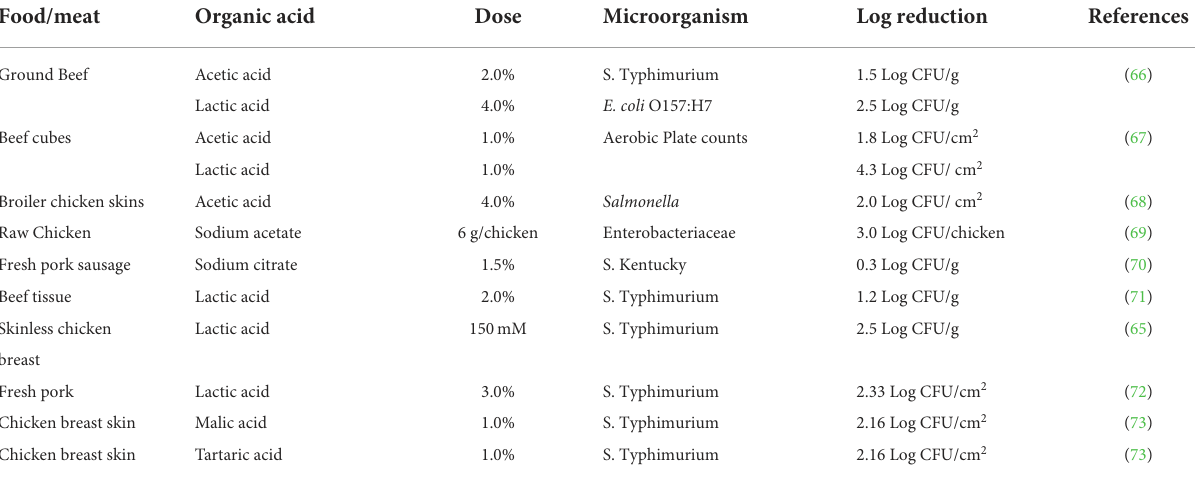
TABLE 1 Summary of antimicrobial efficacy for organic acids at various doses used to control spoilage and pathogenic bacteria in meat and poultry products.